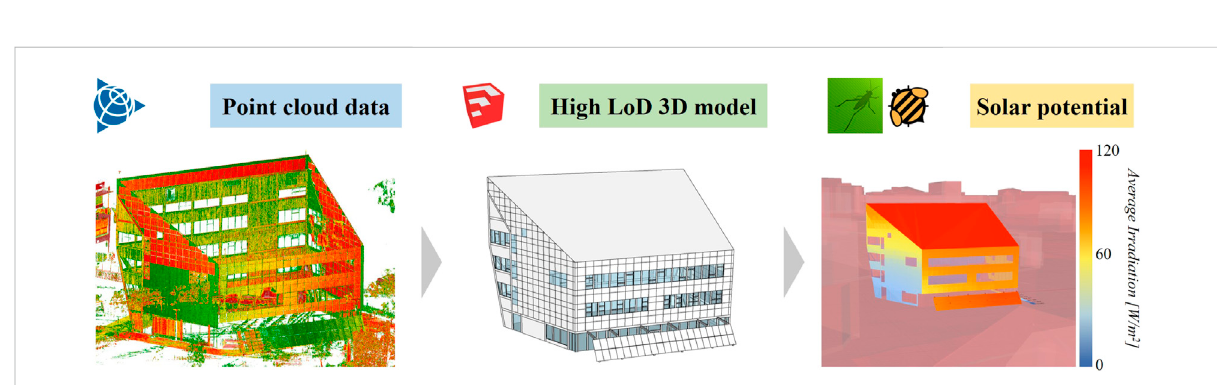
FIGURE 7 Changes in the geometry model from the point cloud data to the high-LoD 3D model of the ZEB Laboratory and to the solar potential analysis.